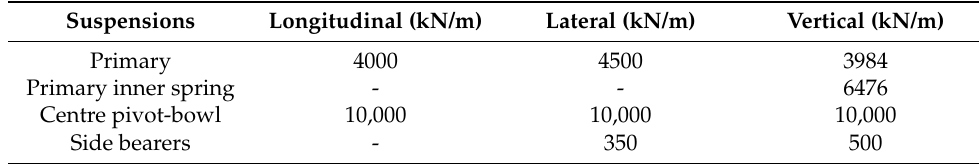
Table 3. Primary suspensions characteristics Reprinted from [17].